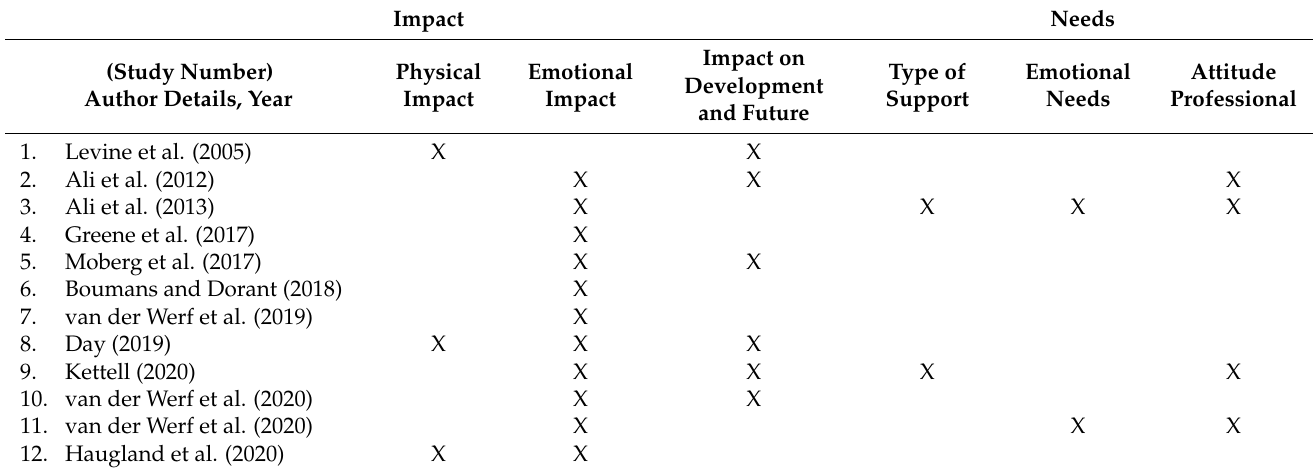
Table 2. Impact and needs of young adult caregivers described in the